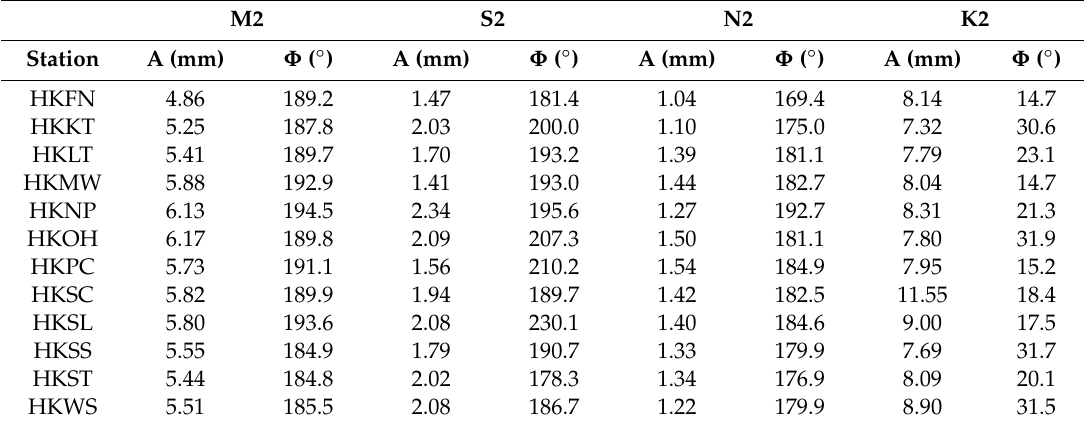
Table A1. KPPP-estimated vertical OTL displacements of four semidiurnal tides.